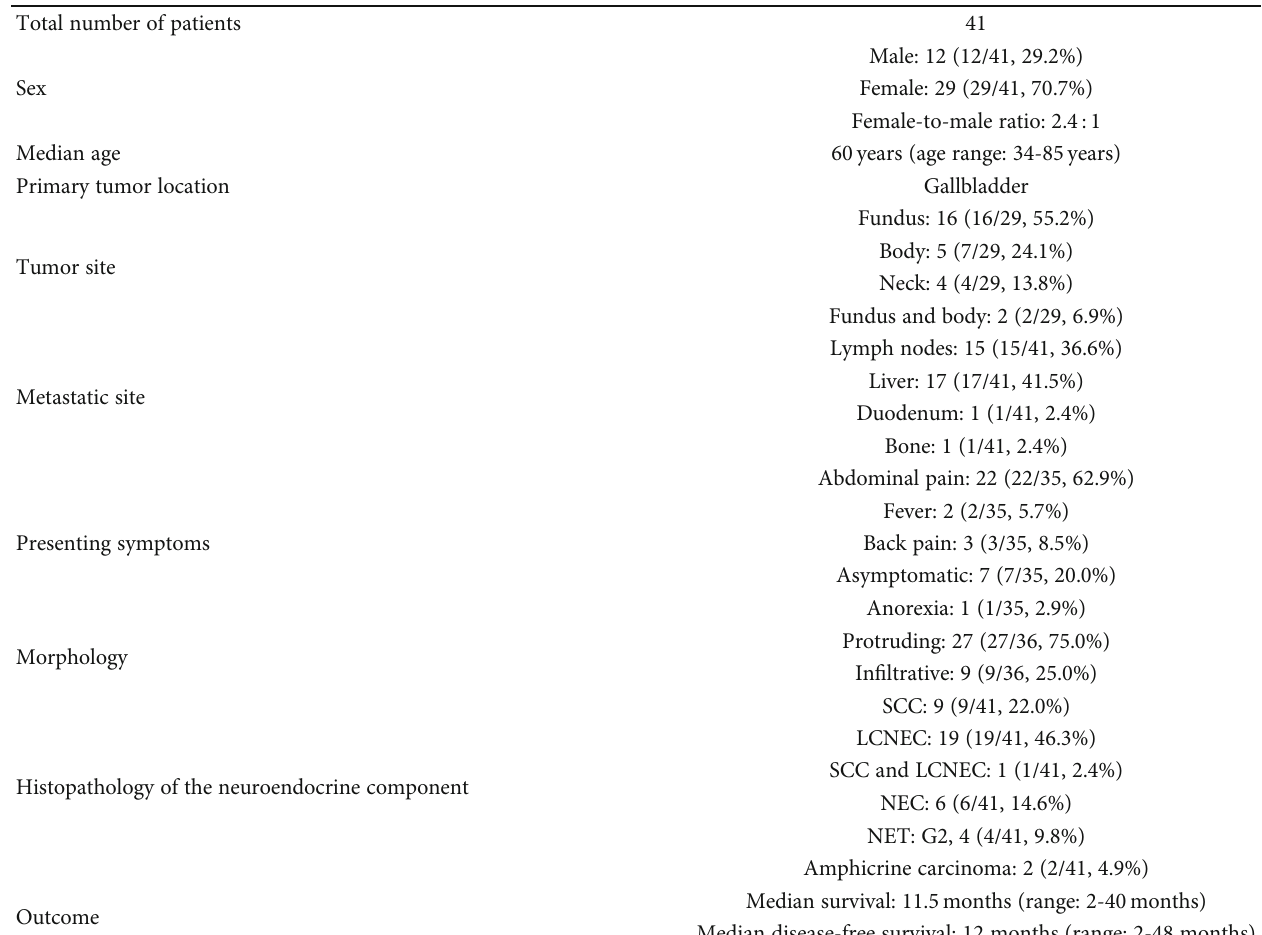
Table 4: Characteristics of 41 previously reported patients with GB-MiNENs, including our current 9